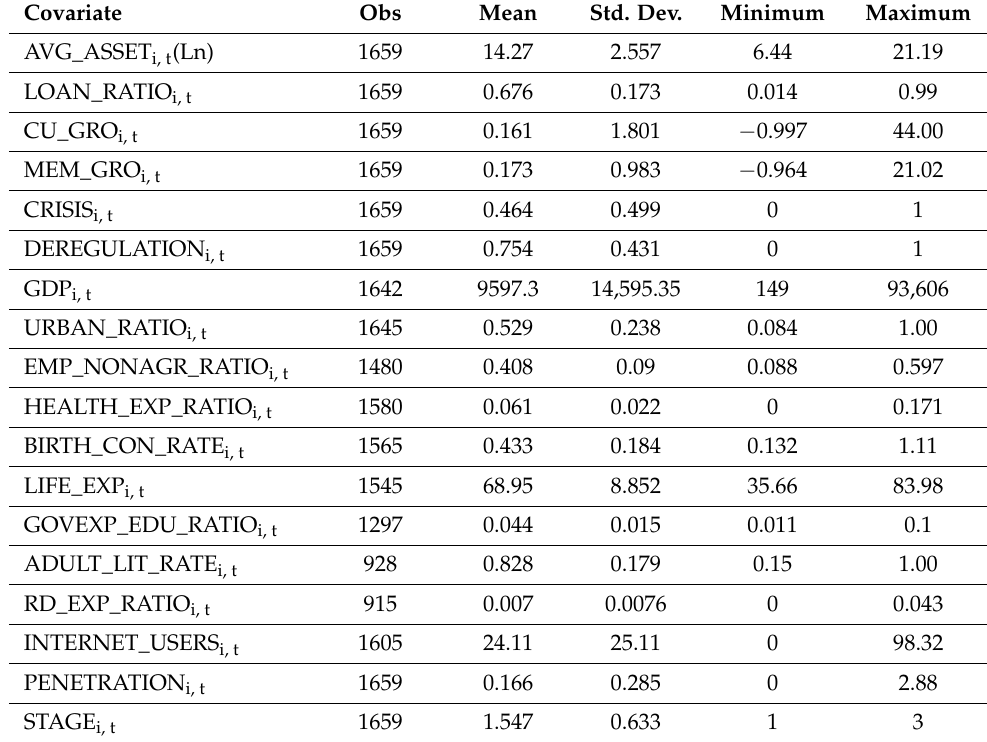
Table 4. Summary statistics: time-varying covariates.